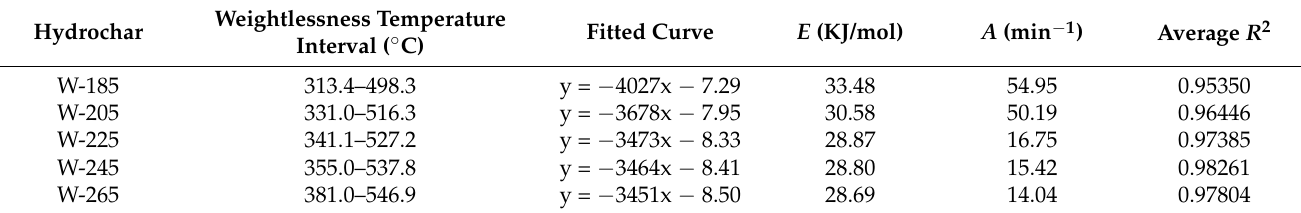
Table 3. Kinetic parameters of hydrochar pyrolysis at different HTC